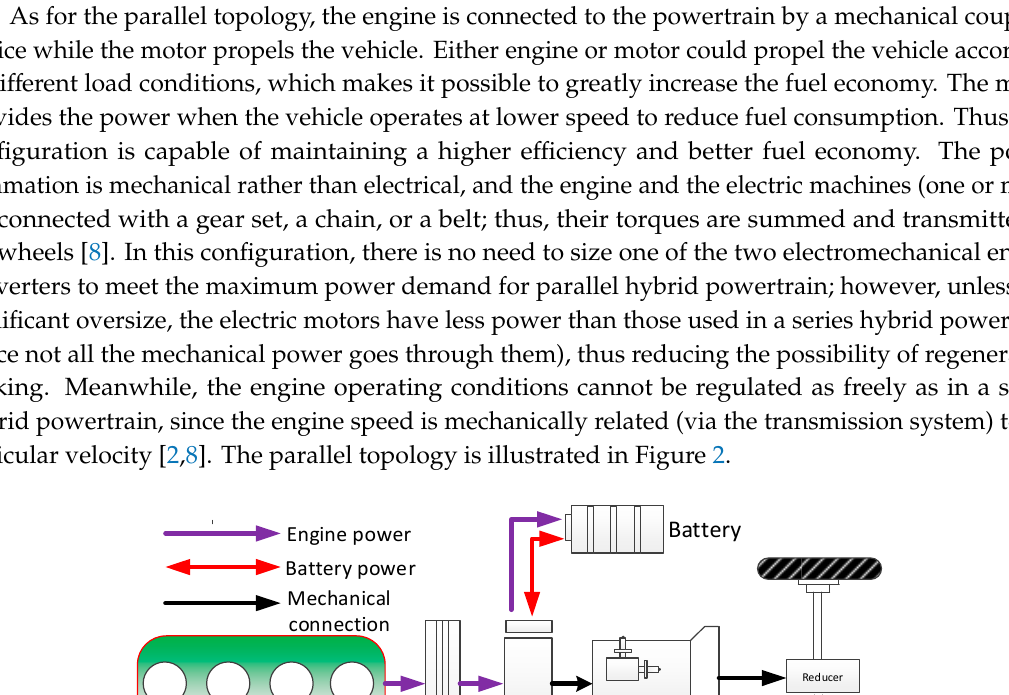
Figure 1. Series hybrid electric vehicle.